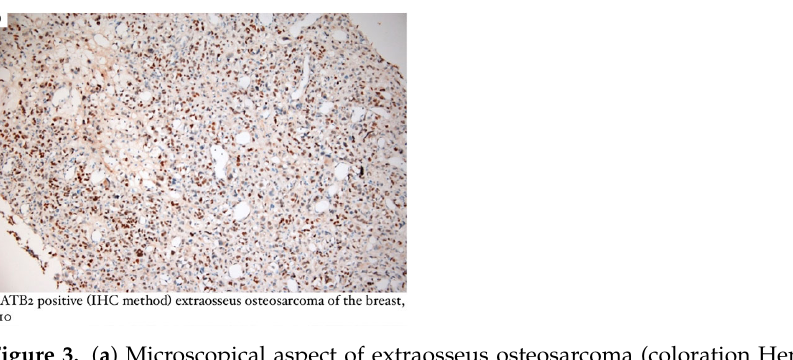
Figure 3. ( a ) Microscopical aspect of extraosseus osteosarcoma (coloration Hematoxylin/Eosin), ×10; ( b ) Ki67 intense positive (IHC method) extraosseus osteosarcoma of the breast, ×10; ( c ) SATB2 positive (IHC method) extraosseus osteosarcoma of the breast, ×10.